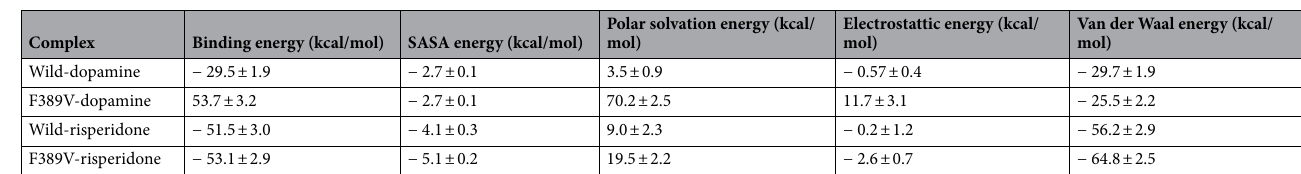
Table 1. Binding free energy calculation of the docked complexes using MM-PBSA